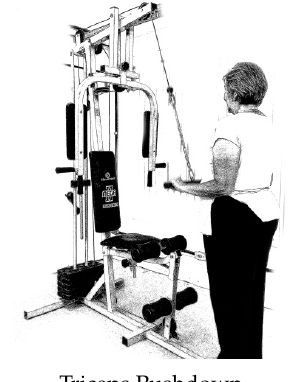
Triceps Pushdown Triceps Pushdown Muscles Worked: Triceps, deltoid, Muscles Worked: Triceps, deltoid, forearm.